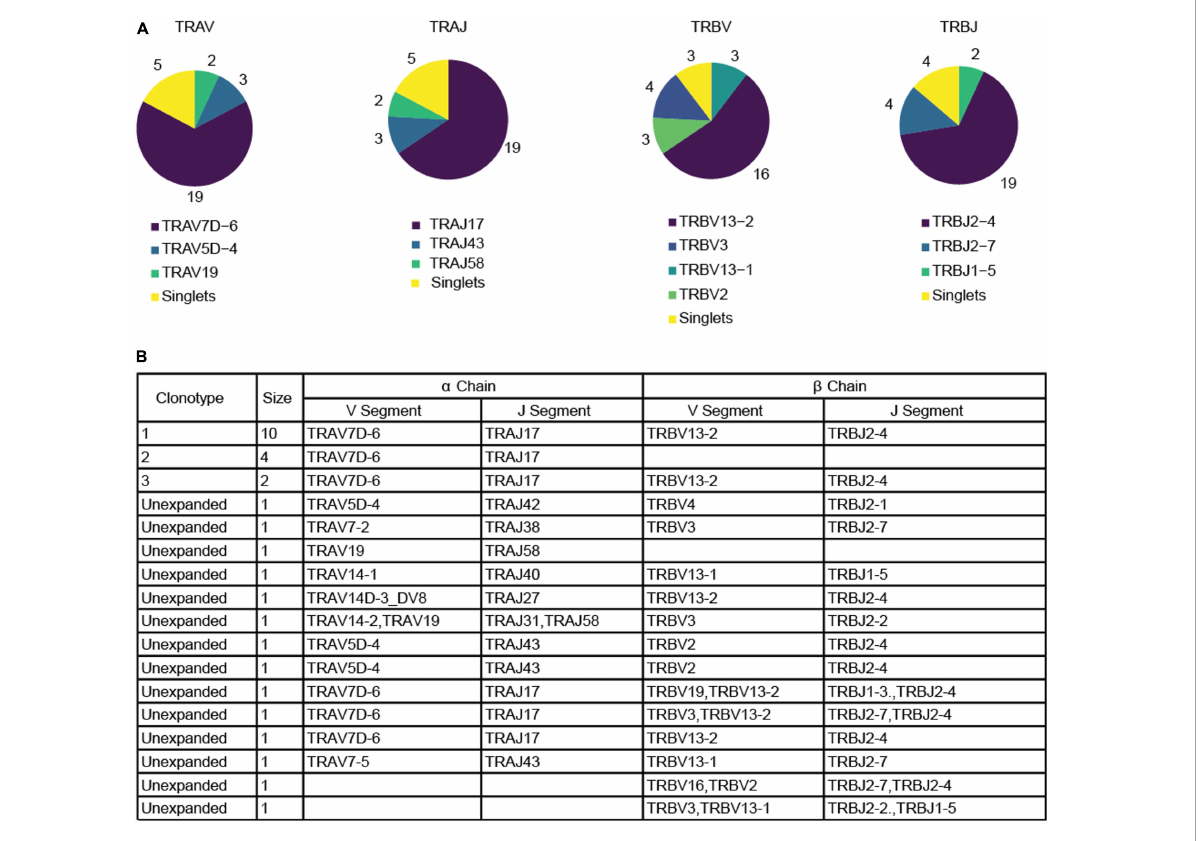
crystal structure of mouse TCR YAe62 (pdb 3C60). CDR1, 2, and 3 for both α (orange) and β (green) are shown in Figure 5A . The ApoB-P6 peptide was placed in the groove of the published crystal structures of mouse I-A b (pdb 1AIO, 2IAD, and 3C60). As expected, residues Y4, A7, S9, and S12 in the 15- mer were anchor residues ( Figure 5B ), with the residues S5, N6, S8, T10, and E11 pointing “up” toward the TCR heterodimer ( Figure 5B ). Residues S5 and N6 contacted TCR α A94 and G95 ( Figure5C ). S8 made contact with TCR β G95. T10 made contact with TCR β R94 ( Figure 5C ). Thus, three contiguous amino acid residues in CDR3 α (AGN) and in CDR3 β (RGR) determined the specificity of this TCR for P6 in the groove of I-A b ( Figure 5D